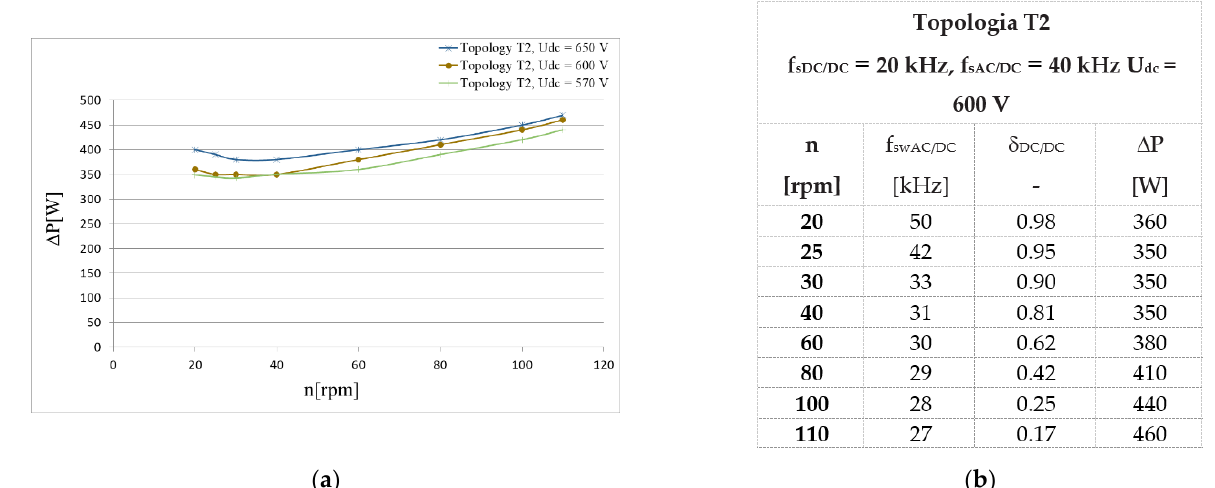
Figure 11. ( a ) Power losses in the topology T2 at different voltages in the DC circuit and ( b ) switching frequency of the grid converter transistors f sw and the generator converter pulse duty δ at U dc = 600